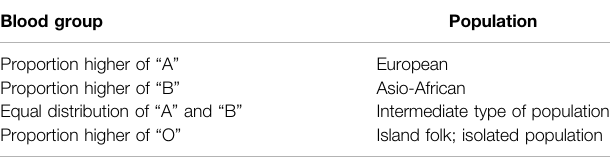
TABLE 2 | The proportion of blood group and population classi fi cation based on Biochemical Racial